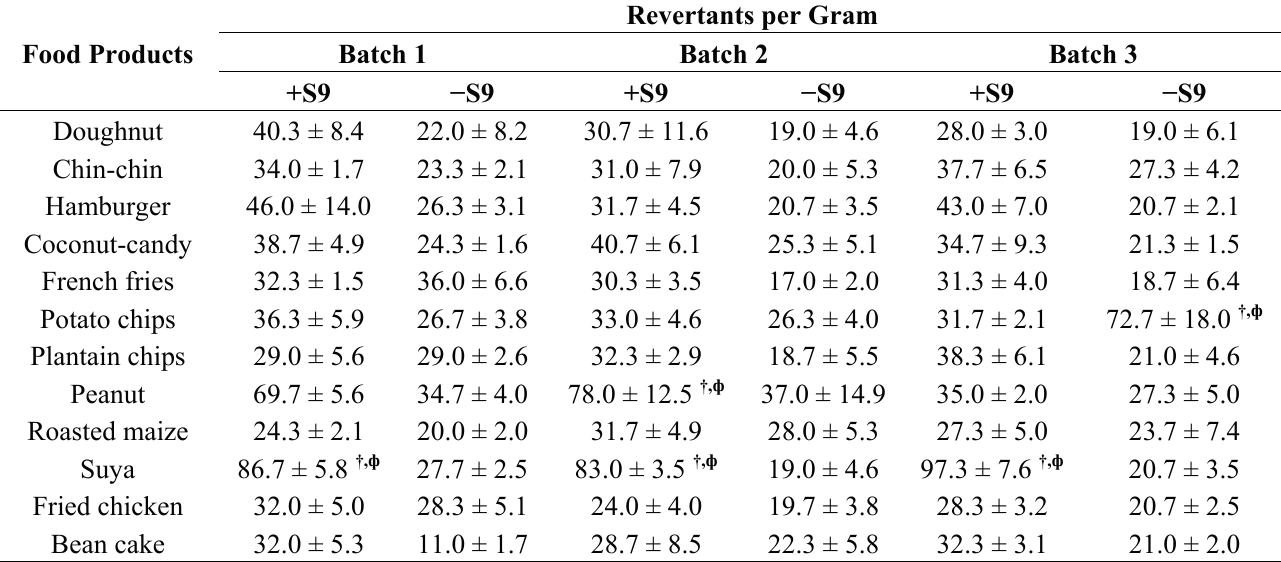
Table 3. Number of revertants generated by the highest concentrations (1.0 per g of food sample) of food extracts on Salmonella TA 98 (mean ± SD) in the standard plate incorporation